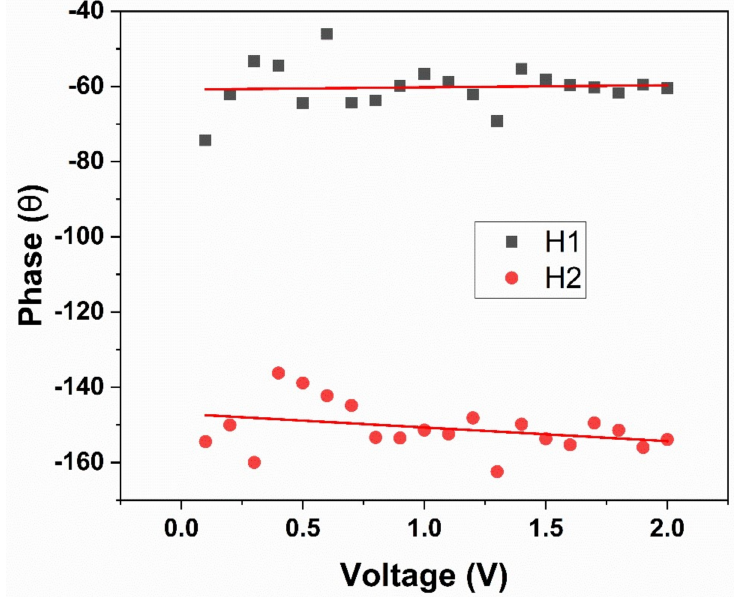
Figure 6. Corresponding phase values for the voltage sweeps of the first and second harmonics of the PFM tip, where the difference of 90 degrees between the two phases can be